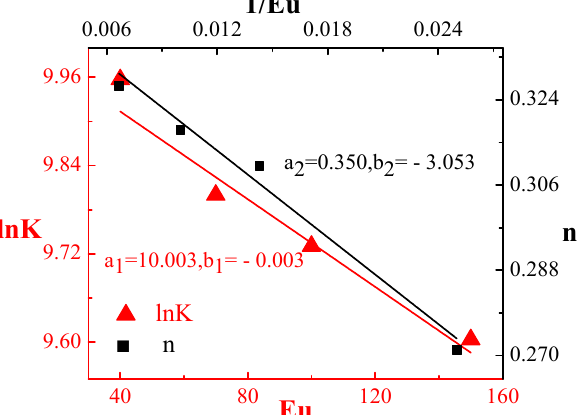
Figure 3. Linear relationships of lnK (consistency index) and non-Newtonian index n with ultrasonic energy Eu.